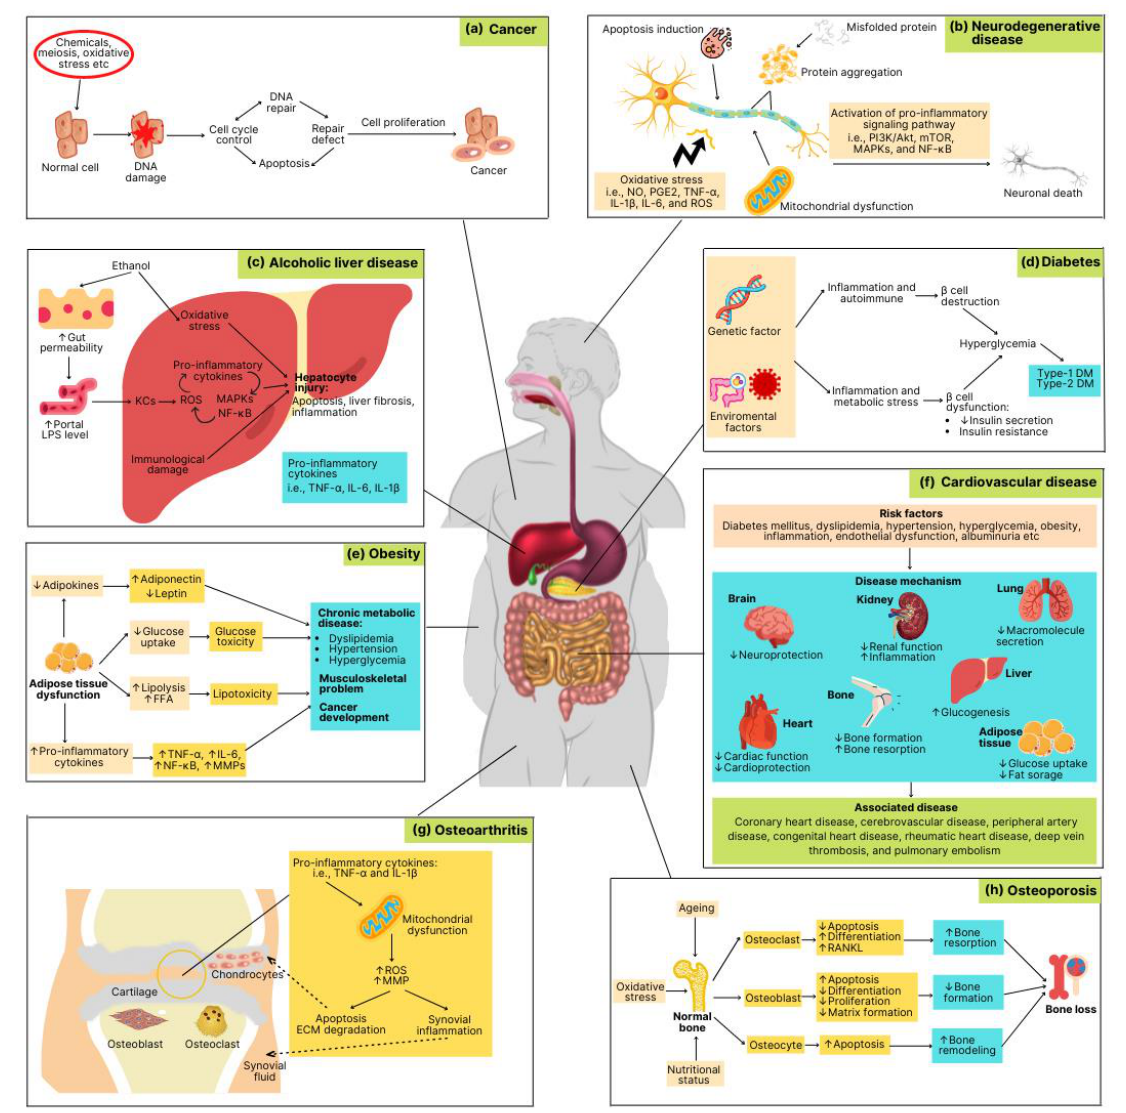
Figure 4. Mechanisms of chronic diseases, including cancer ( a ), neurodegenerative disease ( b ), alcoholic liver disease ( c ), diabetes ( d ), obesity ( e ), cardiovascular disease ( f ), osteoarthritis ( g ) and osteoporosis ( h